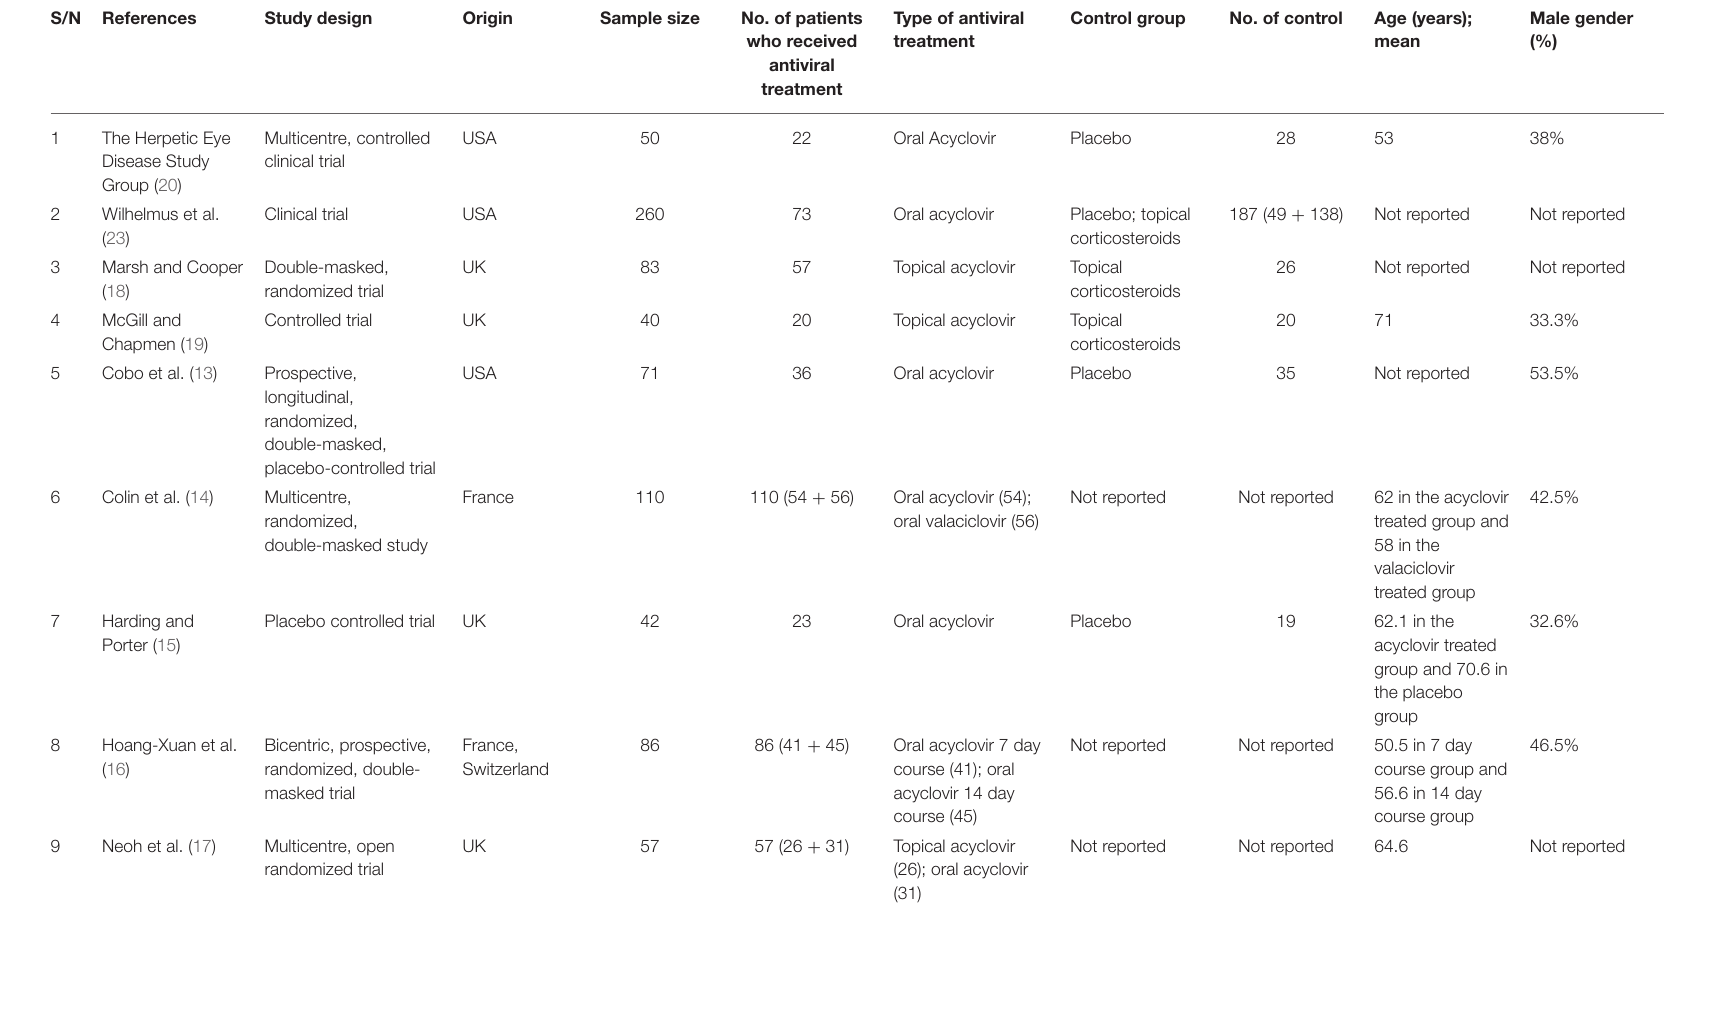
TABLE 1 | Study details and population